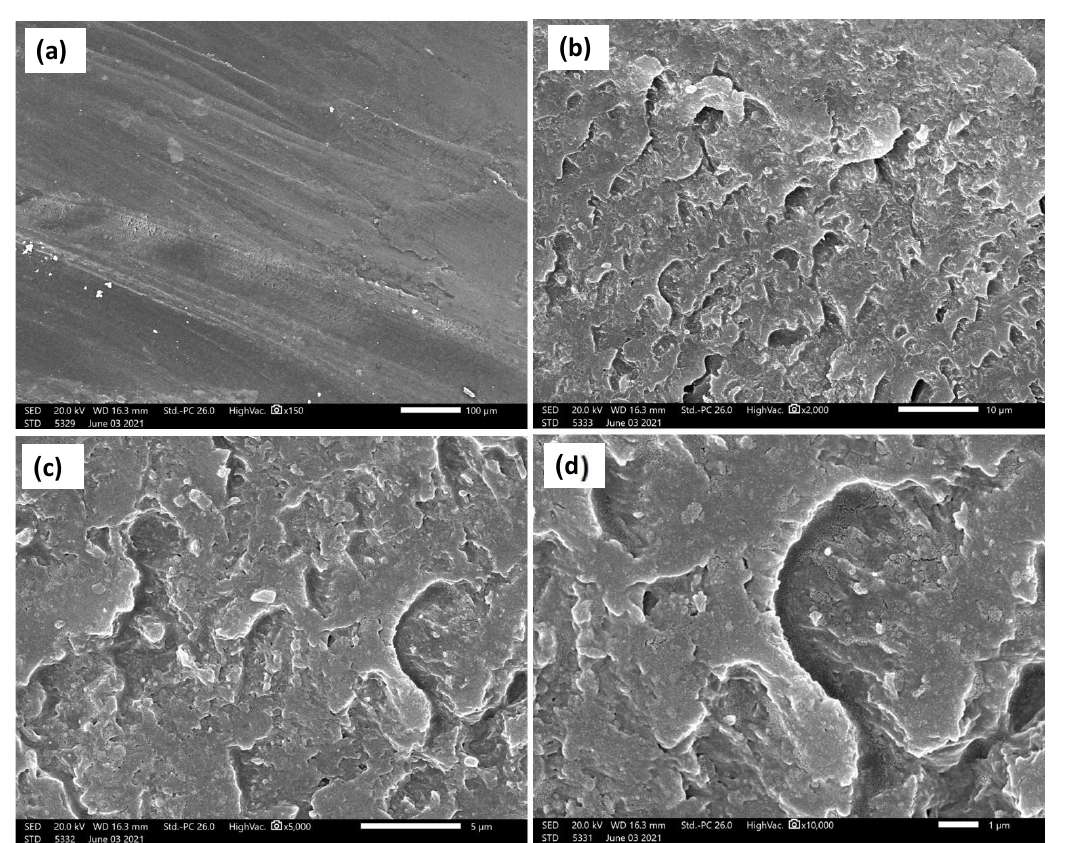
Figure 13. SEM micrographs at different magnifications and positions of the 5 wt% ZrO2 acrylic nanocomposite material after wear test. ( a ) 150 × , ( b )2000 × , ( c ) 5000 × and ( d ) 10,000 × .